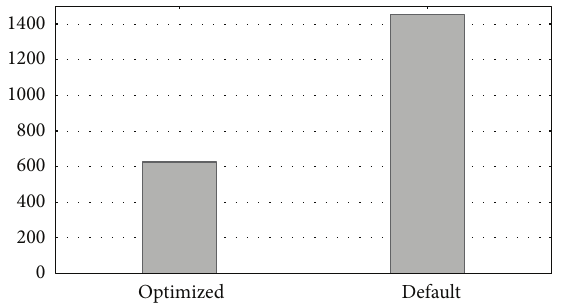
Figure 12: Runtime of a left join using 2 tables. Figure 13: Runtime of a search query to the Processpairstable